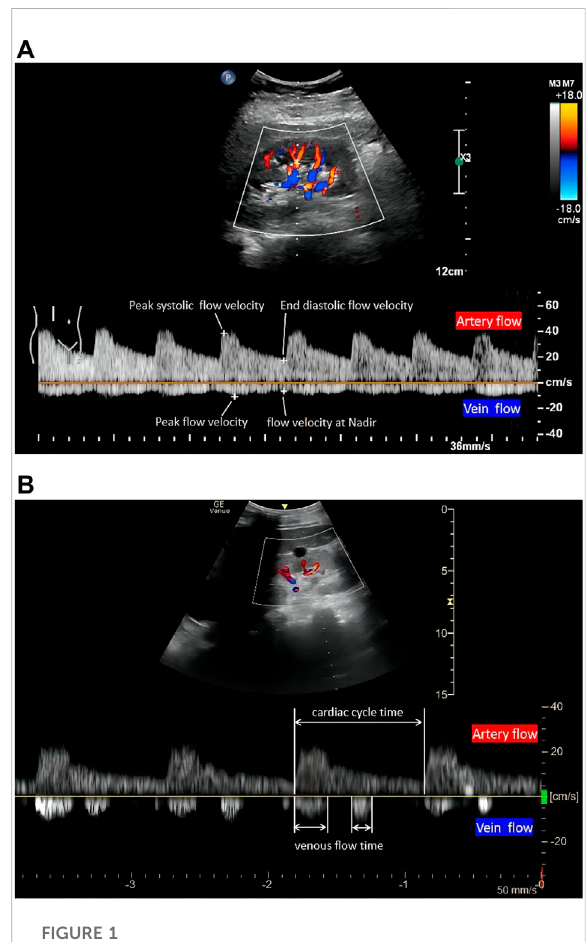
FIGURE 1 The quantitative evaluation of renal hemodynamics by pulse wave Doppler in the interlobar vessels of the right kidney. Intrarenal artery fl ow (upward Doppler signals) and vein fl ow (downward Doppler signals). A continuous venous fl ow pattern in (A) and a biphasic pattern in (B) (1). RRI, (peak systolic fl ow velocity-end diastolic fl ow velocity)/peak systolic fl ow velocity. (2) PI, (peak systolic fl ow velocity-end diastolic fl ow velocity)/mean fl ow velocity. (3) VII, (peak fl ow velocity- fl ow velocity at nadir)/peak fl ow velocity. (4) RVSI, (cardiac cycle time- venous fl ow time)/cardiac cycle time. RRI, renal resistive index; PI, renal pulsatility index; VII, venous impedance index; RVSI, renal venous stasis